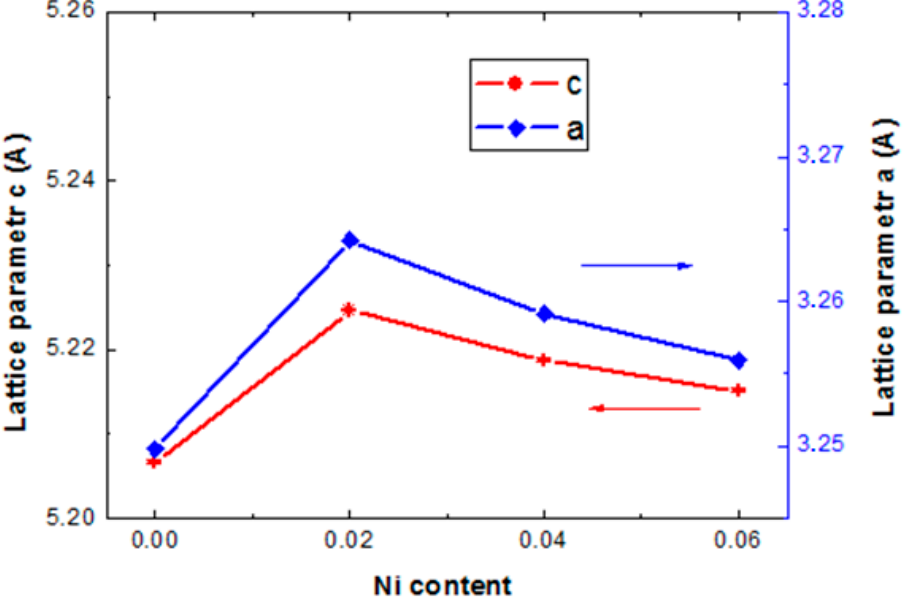
Figure 2. Dependence of the lattice parameters “a” and “c” on the increasing Ni content (x) in Zn 1 − x Ni x O films.